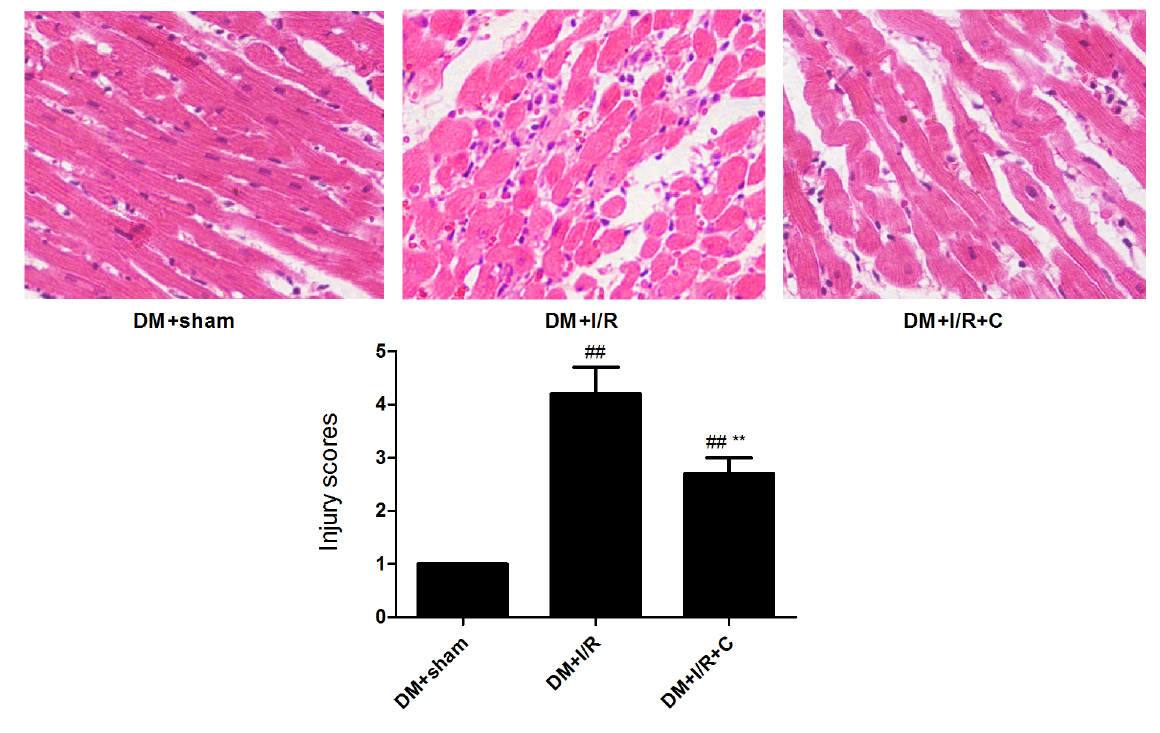
Figure 8. Effects of catalpol on myocardial histopathology in diabetic rats (400